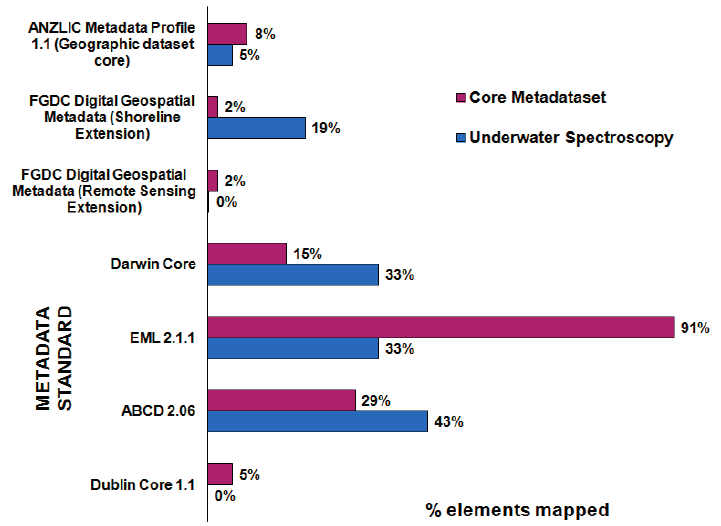
Figure 4. Successful mappings from existing metadata standards to the field spectroscopy metadatasets as a percentage of the total number of elements mapped in the core metadataset and the benthic reflectance